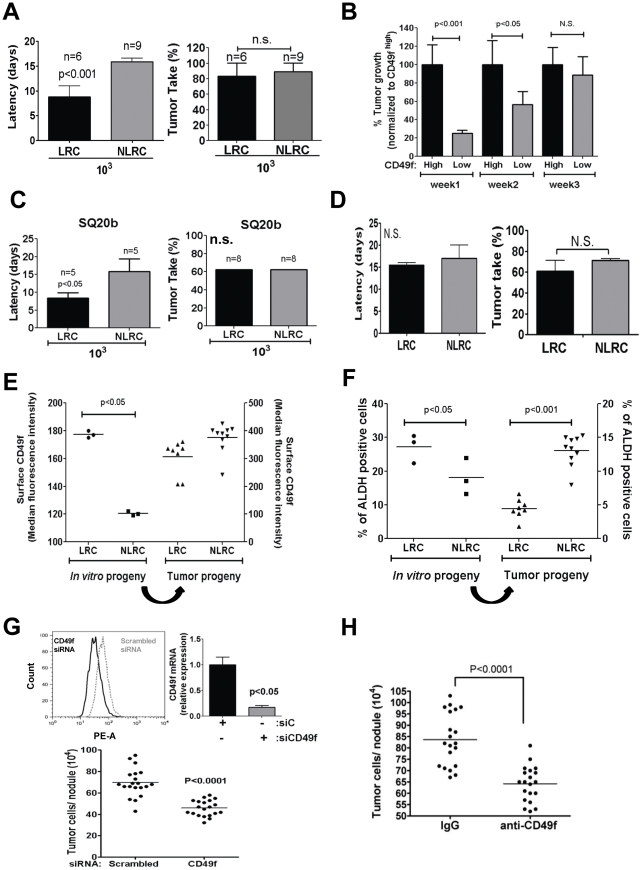
CD49flow/NLRCs can regain their tumorigenic capacity and restore CD49f and ALDH1A1 expression.(A) Tumor latency (left panel) and tumor take (Right panel) of HEp3 LRCs and NLRCs that were injected in nude mice (103 cells/mice). Graphs show mean ± SD. The numbers represent the number of animals per group. (B) Quantification of tumor growth by CD49fhighand CD49flow HEp3 cells upon serial transplantation on CAMs (1–3 weeks). (C) Tumor latency (left panel) and tumor take (Right panel) of SQ20b LRCs and NLRCs that were injected in NSG mice with matrigel (103 cells/mice). Graphs show mean ± SD. The numbers represent the number of animals per group. (D) Tumor latency (left) and tumor take (right) of the progeny of HEp3 LRCs and NLRCs after expansion in culture and injection in nude mice. (E–F) FACS analysis of surface CD49f (E) and ALDH1A1 (F) expression in the in vitro expanded progeny of LRCs and NLRCs (in vitro progeny) (Left part of the graph) and in tumors from the progeny of the LRCs and NLRCs expanded in culture (Tumor progeny)( Right part of the graph). (G) Quantification of HEp3 tumor growth after inhibition of CD49f using siRNA (Lower graph). Inhibition of CD49f expression was measured by FACs (upper left panel) and qPCR (upper right panel) (siC = SiRNA scrambled; siCD49f = siRNA CD49f). (H) Quantification of HEp3 tumor growth after treatment with a CD49f blocking antibody or an isotype matched IgG. p-values estimated using Mann-Whitney non-parametric test.